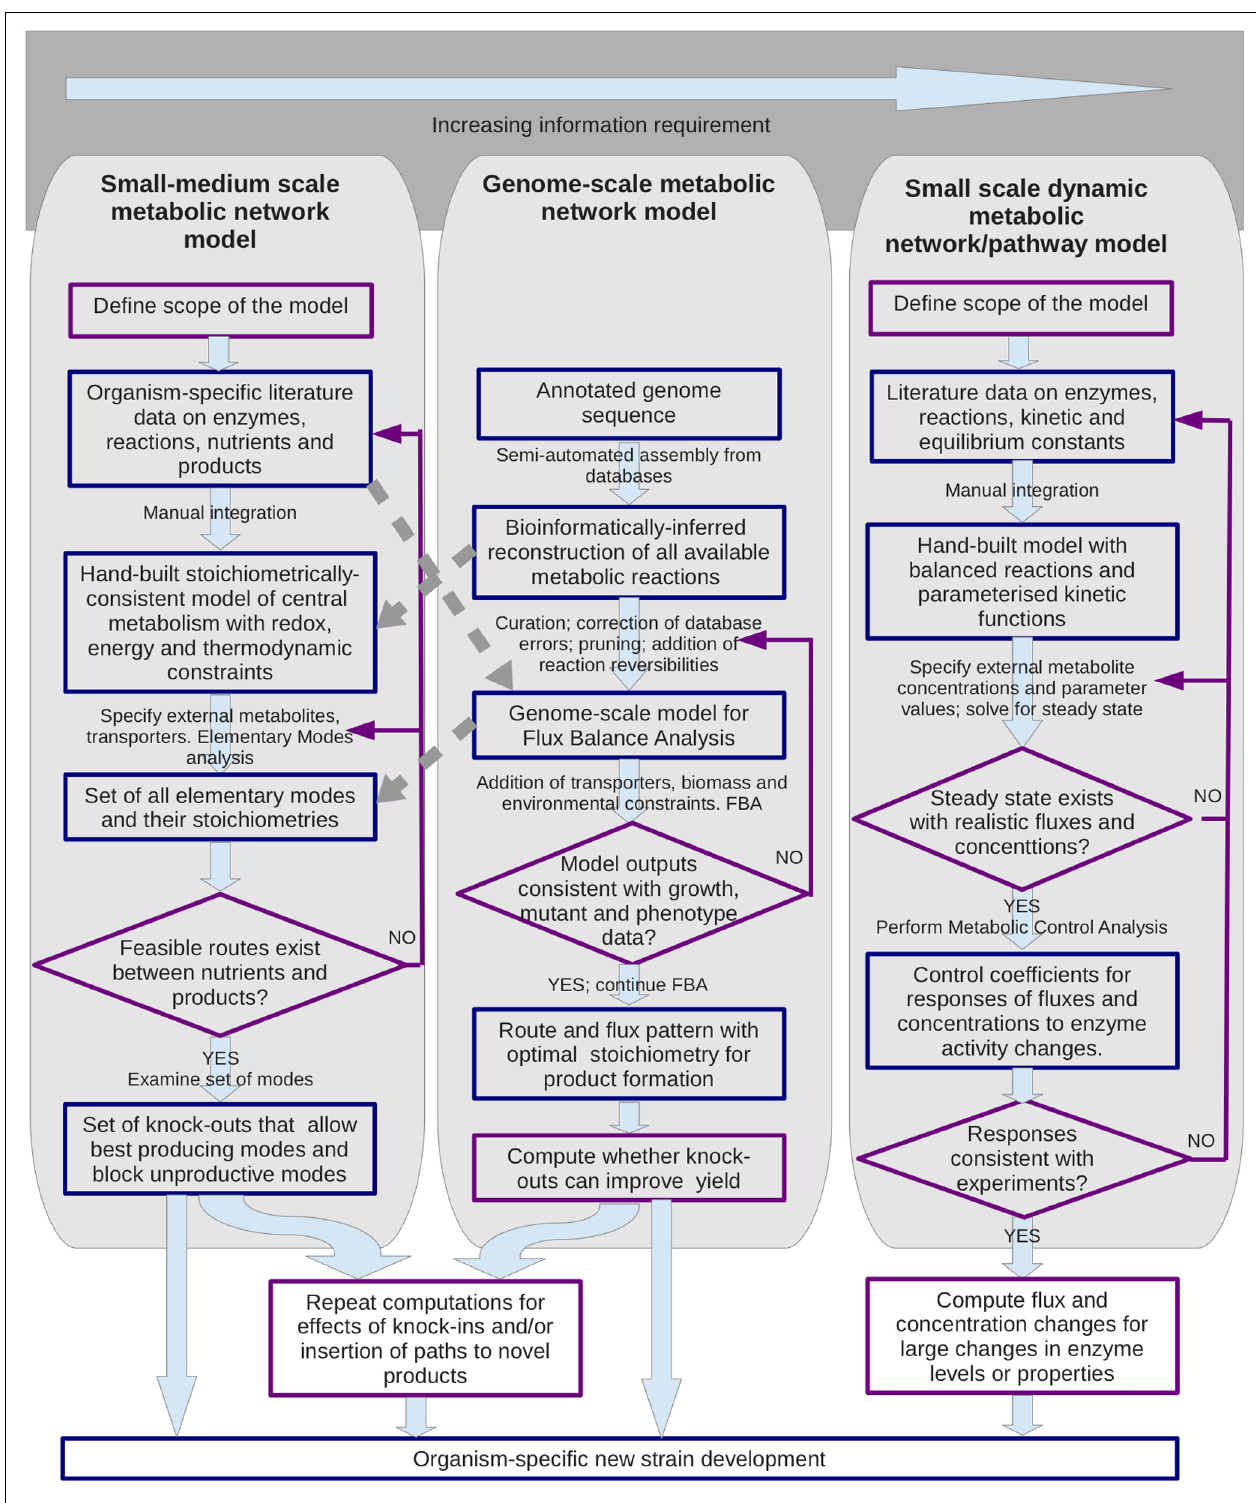
FIGURE 1 | Metabolic modeling support for metabolic engineering strategies. Three main types of modeling approach are shown that have been used to analyze metabolic networks and to design alterations. The methodologies for the two structural modeling